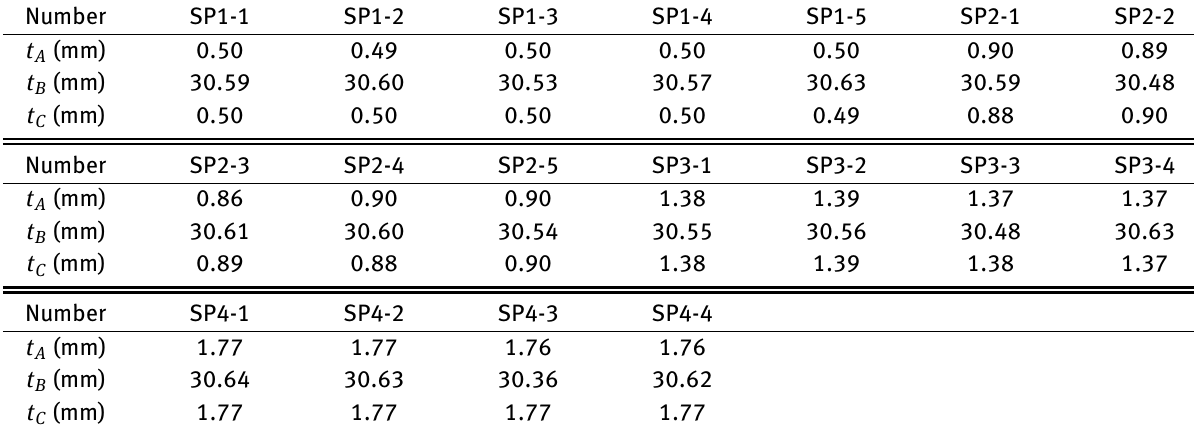
Table 2: Geometric parameters of 18 sandwich